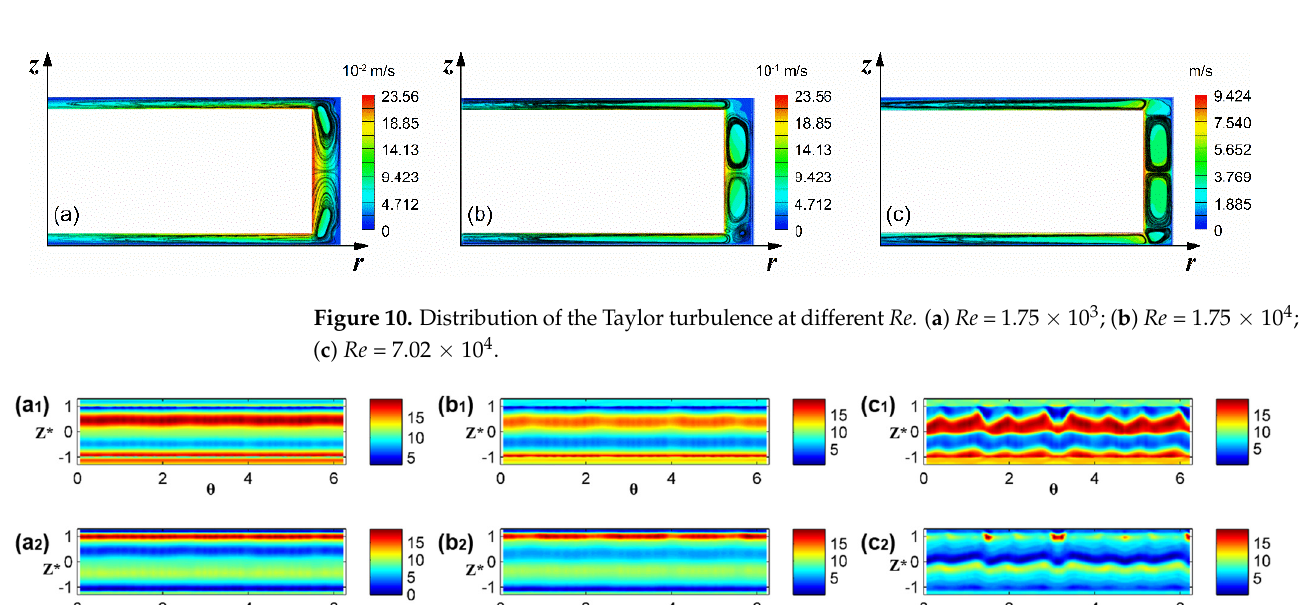
Figure 11. Cloud image of intensity distribution of spiral vortices. ( a 1 , b 1 , c 1 ) are 10 μ m to the lateral lateral wall of the rotor; ( a 2 , b 2 , c 2 ) are 10 µ m to the lateral wall of the cavity; ( a ) Re = 1.75 × 10 3 ; wall of the rotor; ( a 2 , b 2 , c 2 ) are 10 μ m to the lateral wall of the cavity; ( a ) Re = 1.75 × 10 3 ; ( b ) Re = 1.75 × 10 4 ; ( c ) Re = 7.02 × 10 4 . ( b ) Re = 1.75 × 10 4 ; ( c ) Re = 7.02 × 10 4